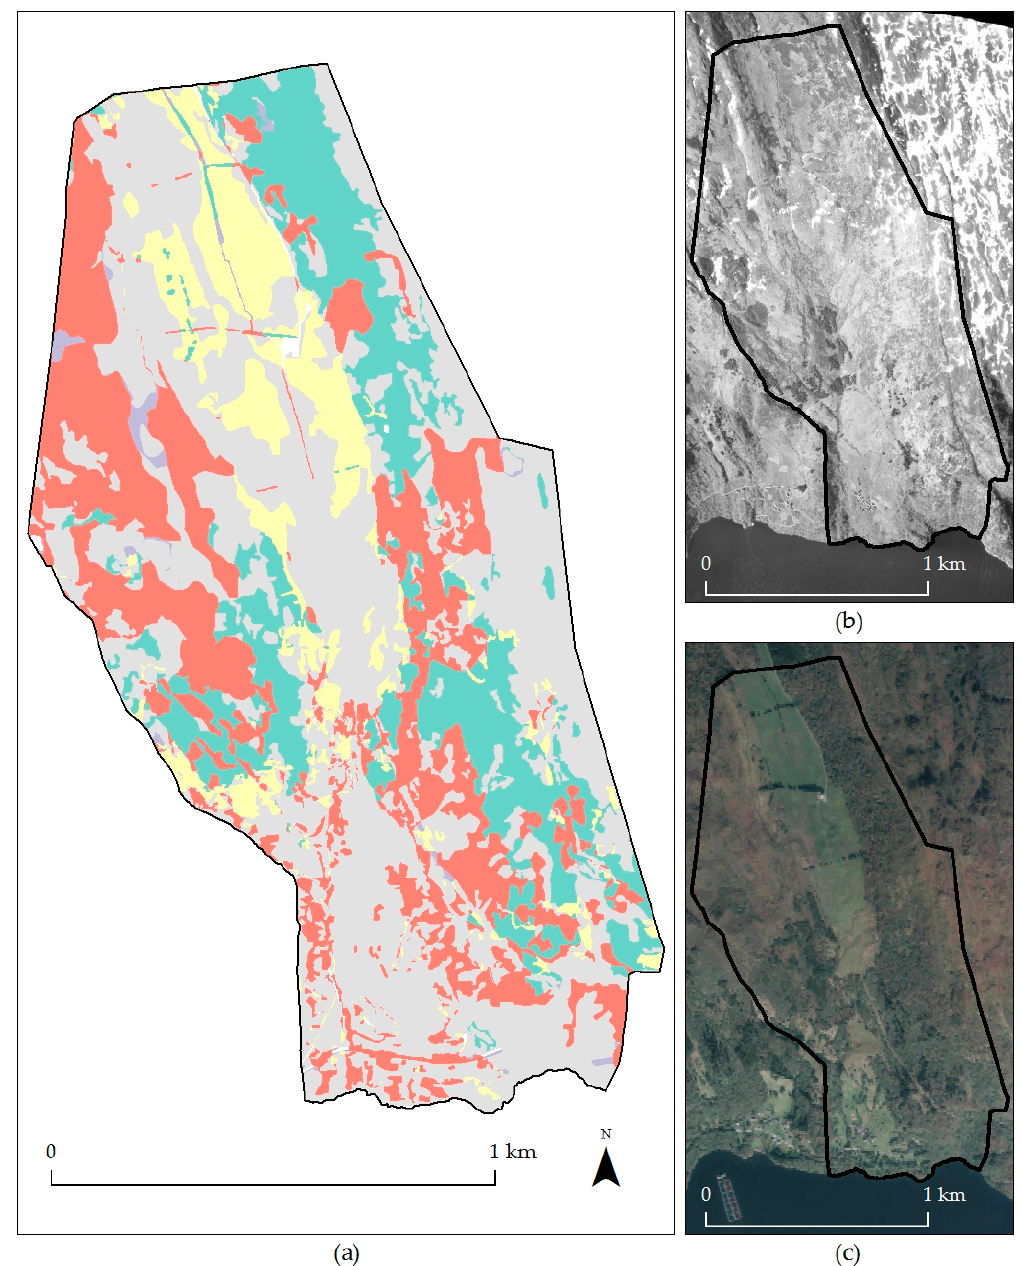
Figure 3. Land cover change map ( a ), resulting from an overlay of interpretations of aerial photographs from 1951 ( b ) and 2013 ( c ). Grey signifies areas that have the same land type in both years. Red shows areas that were used for agriculture in 1951 but have been converted to other land types in 2013. Yellow shows the opposite change, conversion to agriculture. Green shows forestation of unmanaged open land or wetlands, whilst purple shows the opposite change (see also Table 3). Aerial photos: https://norgeibilder.no.